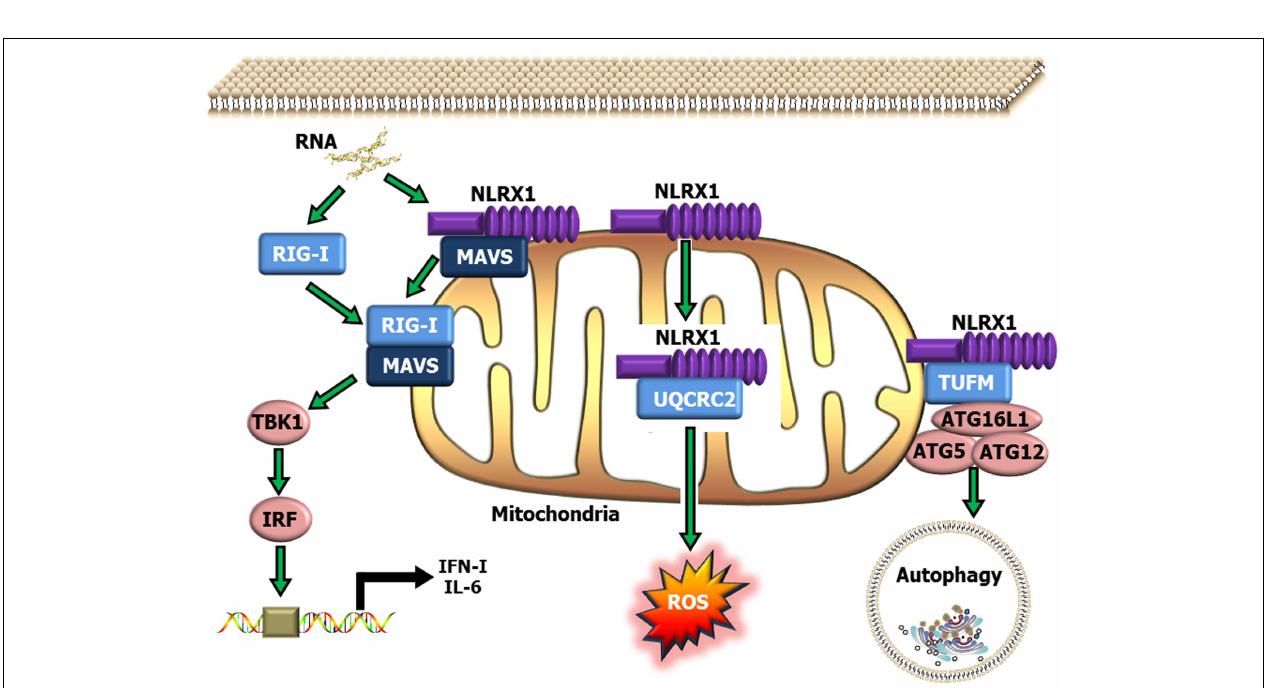
proteinTUFM, and the mitochondrial immune signaling complex (MISC), which includes Atg5–Atg12 and ATG16L1.This complex has been shown to be important in promoting virus-induced autophagy and concurrently attenuating IFN signaling. In addition to its role in attenuating host anti-viral signaling, NLRX1 has also been shown to significantly augment ROS generation from the mitochondria through interactions with UQCRC2 following infection with specific species of